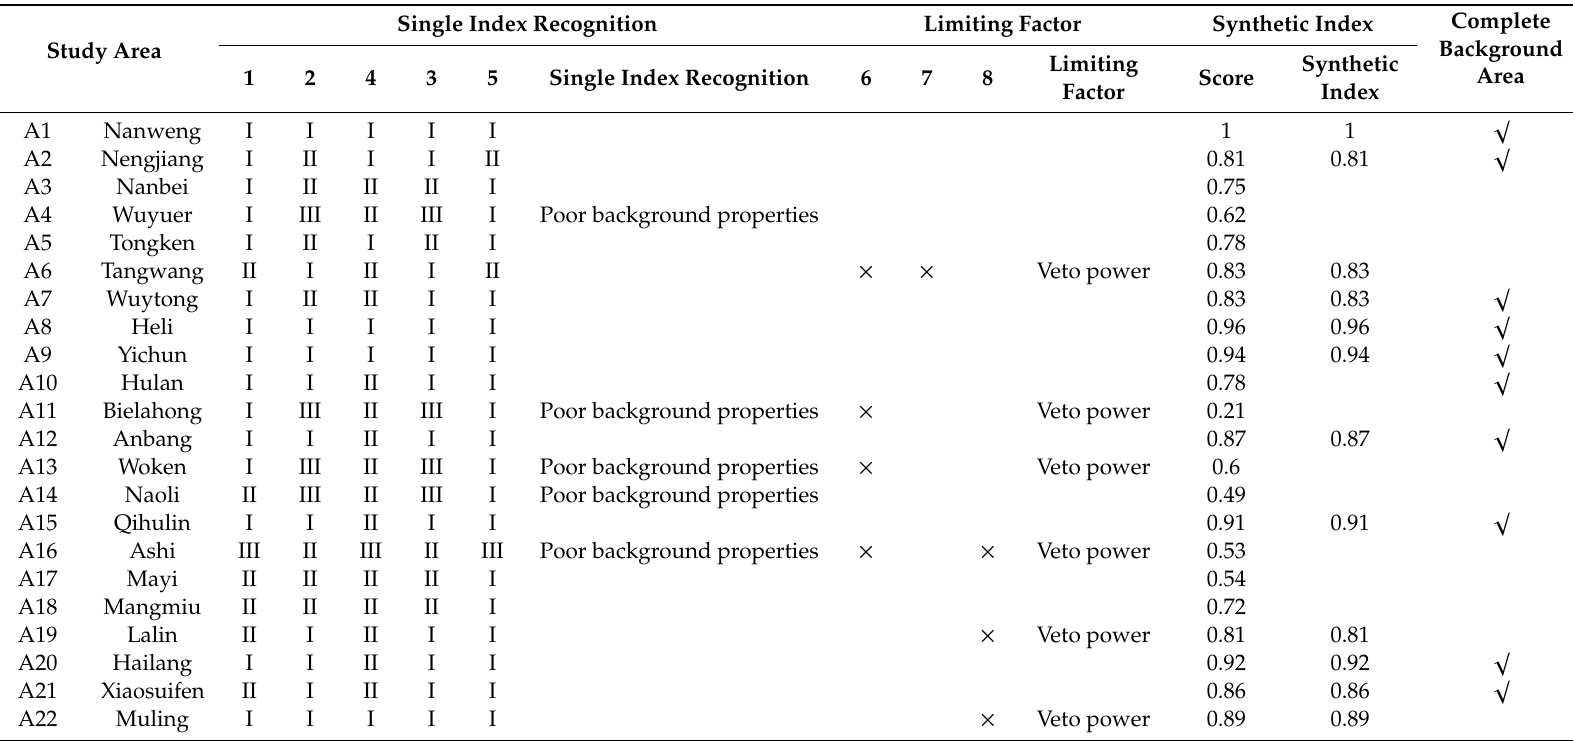
Table 4. Three-step discrimination results for each study area. I, II, and III stand for high background properties, transition area, and poor background properties in single index recognition, respectively; × indicates a limiting factor in the study